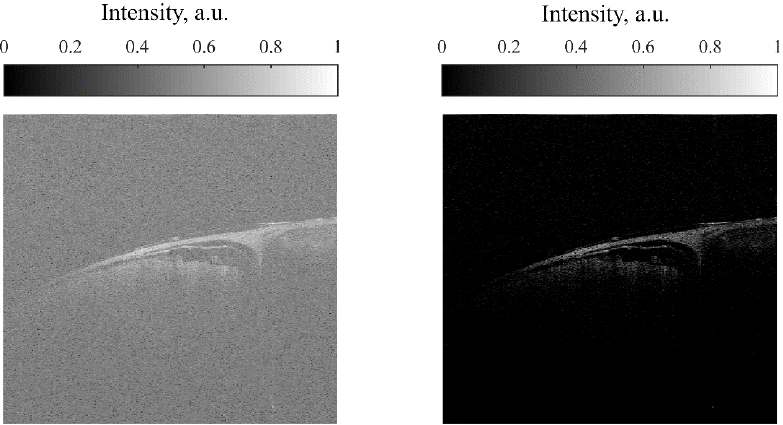
Fig. 11. Raw — left and intensity adjusted — right B-scan.